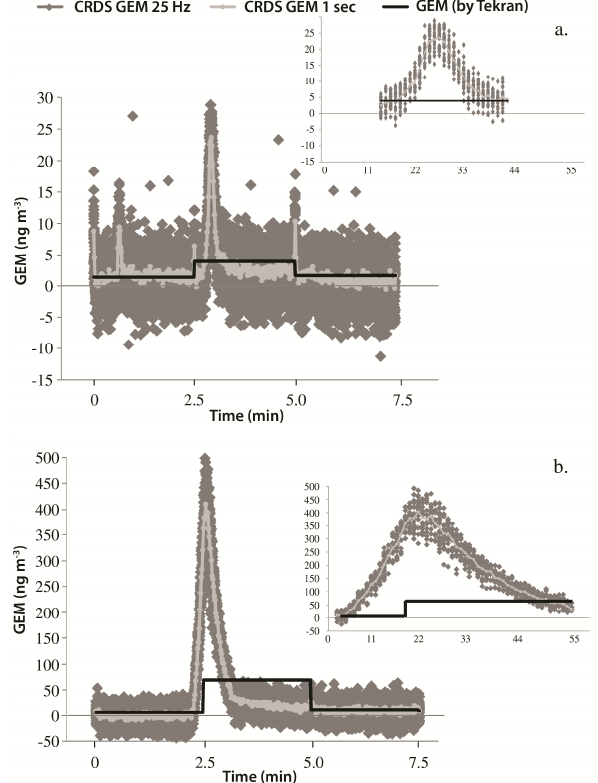
Fig. 9. High-resolution CRDS measurements on 15 June 2012 with short GEM spike additions to ambient air, and comparison to measurements using a Tekran Hg analyzer. CRDS measurements are shown at 25Hz and 1s time resolutions, while Tekran mea- surements are shown at 2.5min resolution. (a) 4ngm − 3 spike, (b) 70ngm − 3 spike. Insets for both panels include only the spike